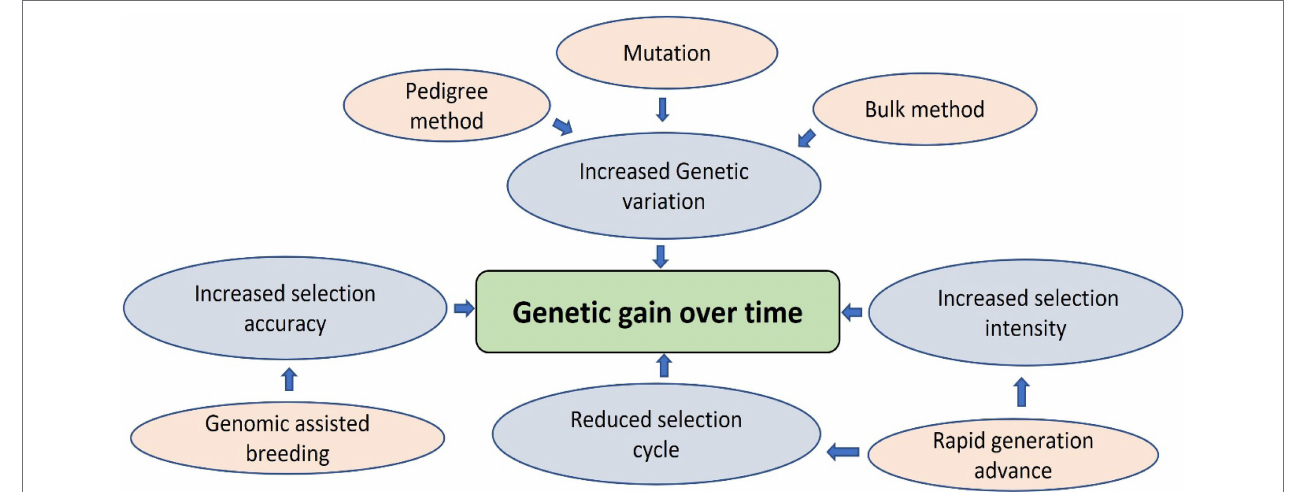
FIGURE 3 | Strategies to increase genetic gain over